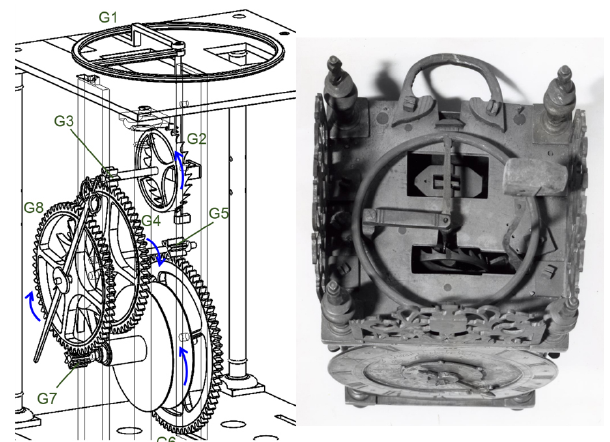
Figure 22. Structure and operation of the N8 going system (British Museum,